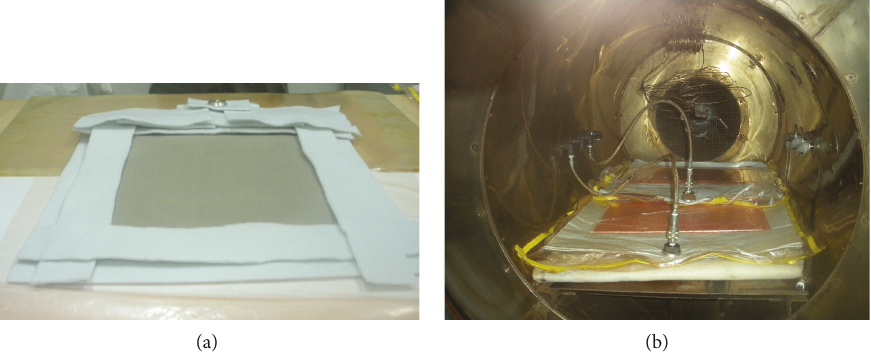
Figure 7: (a) Breather/bleeder around the preform and (b) laminated panel in the autoclave.